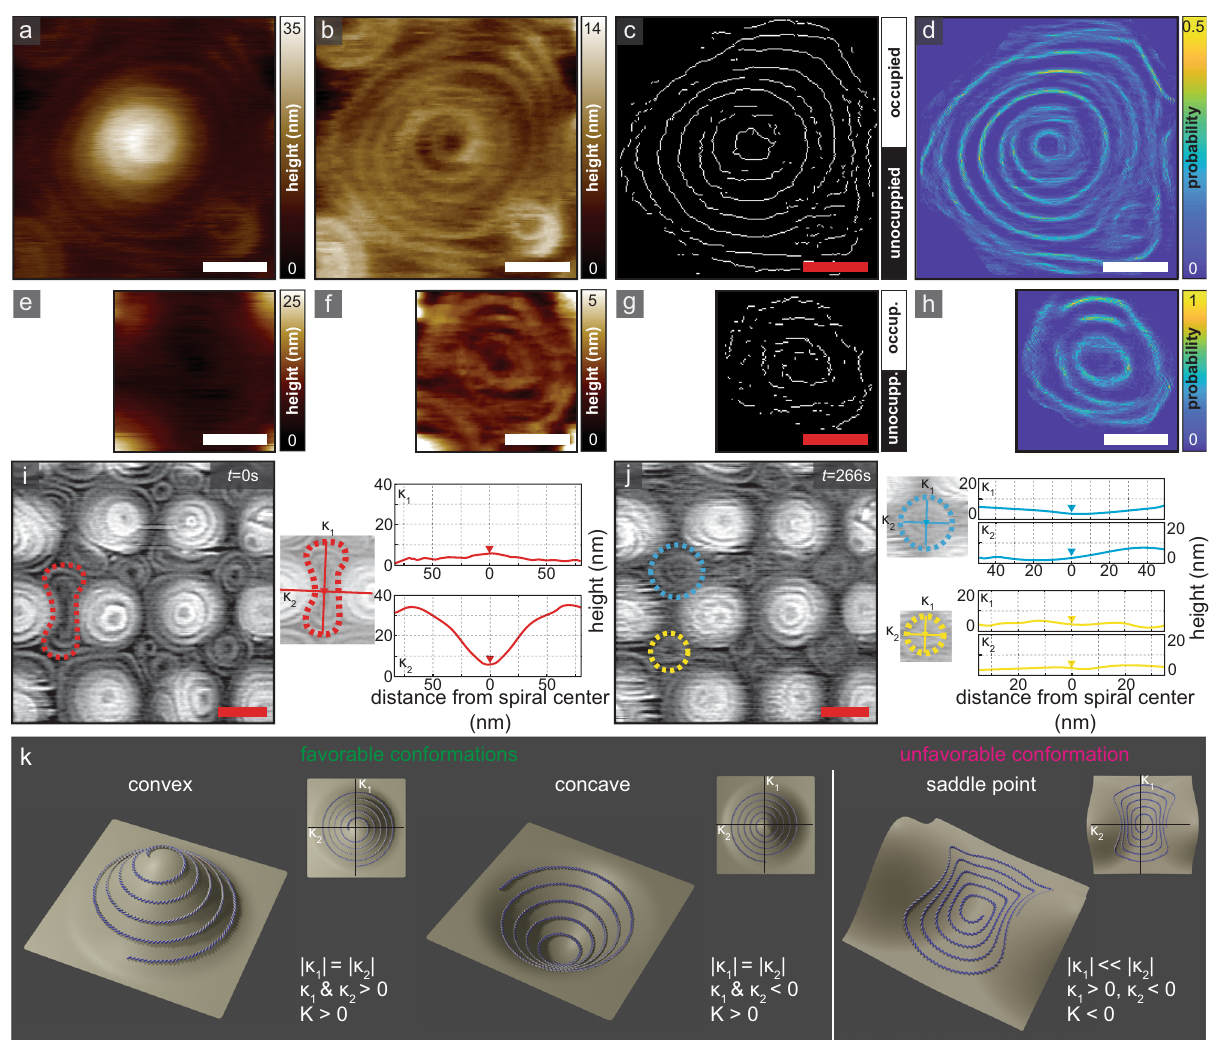
Fig. 4 Membrane curvature-dependent Snf7 spiral stability and reshaping. a HS-AFM, b Gaussian fi tting fl attened, c binarized, and d probability map of a single, large apical Snf7 spiral. The spiral displayed no reshaping over ∼ 5 min HS-AFM observation (Supplementary Movie 4). e HS-AFM, f Gaussian fi tting fl attened, g binarized, and h probability map of a single interstitial Snf7 spiral. The spiral displayed no reshaping over the ∼ 2 min HS-AFM observation (Supplementary Movie 5). Scale bars: ( a – h ) 50 nm. i , j HS-AFM images of Snf7 spirals on an undulated support. A spiral on a saddle-shaped region (outlined in red in i ) remodels into interstitial spirals (yellow and cyan in j ) (Supplementary Movie 6). The line pro fi les (right) show the principal curvatures of the spirals. k Schematic illustrating an isolated Snf7 spiral adapting to convex and concave membrane geometry with rotationally symmetric principal curvatures (left and center, respectively) and a saddle point, where principal curvatures are of opposite signs and different magnitude (right). Source data are provided as a Source Data fi